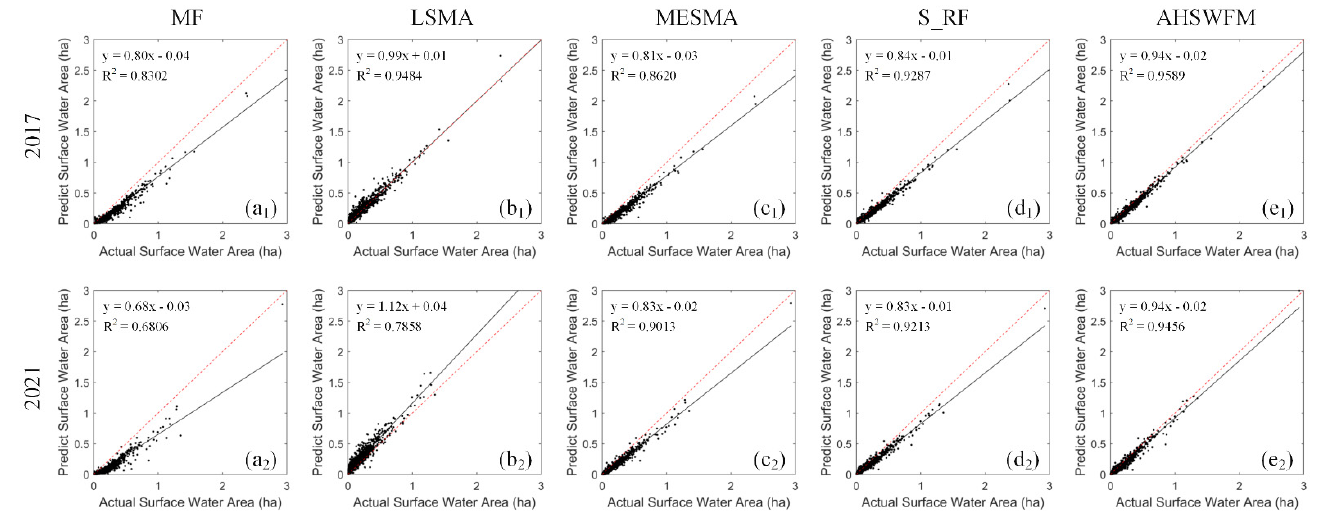
Figure 9. Comparison between actual surface water area (from digitized water maps) and predicted surface water area (from all five methods). ( a 1 , a 2 ) matched filtering (MF) scatterplots, ( b 1 , b 2 ) linear spectral mixture analysis (LSMA) scatterplots, ( c 1 , c 2 ) multiple endmember spectral mixture analysis (MESMA) scatterplots, ( d 1 , d 2 ) self-trained random forest regression (S_RF) scatterplots and ( e 1 , e 2 ) automatic and hierarchical surface water fraction mapping (AHSWFM) scatterplots. The 1:1 line is shown as a red dotted line. S_RF and AHSWFM with a window size of 10 and a fixed window shift in the aggregation to coarse pixel samples in the water fraction regression were used. Table 1. Accuracy statistics of five methods in two years. The lowest root mean square errors (RMSE) values are highlighted in bold. Self-trained random forest regression (S_RF) and automated and hierarchical surface water fraction mapping (AHSWFM) with a window size of 10 and a fixed window shift in the aggregation to coarse pixel samples in the water fraction regression were used.